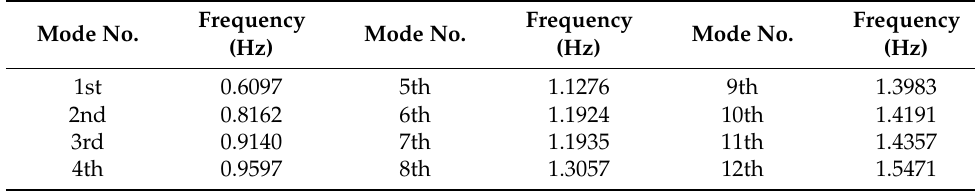
Table 3. FE model-derived modal frequencies.